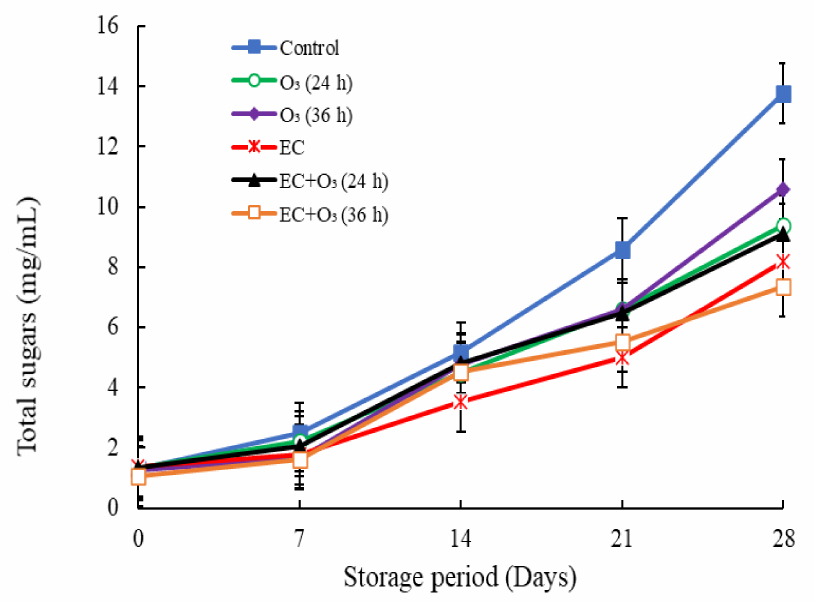
Figure 8. Effect of edible coating (EC) and gaseous ozone (O 3 ) on total sugars of mango fruit during storage at 10 ◦ C for twenty-one days and shelf-life at ambient temperature for seven days ( ± SE, n =